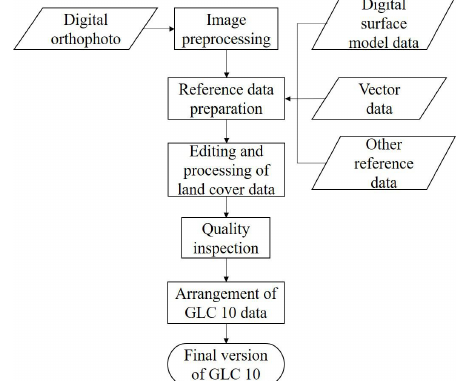
Figure 1 . The production process of GLC 10